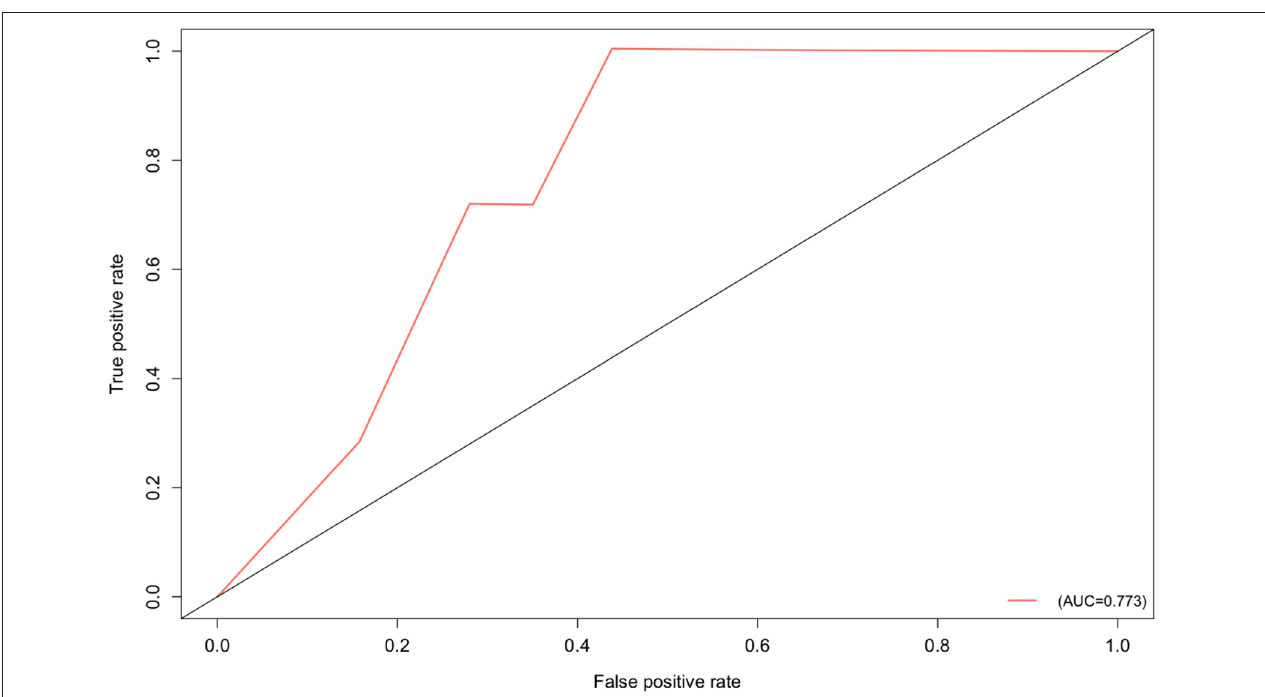
FIGURE 6 | ROC and AUC of RSF model to predict VT/VF